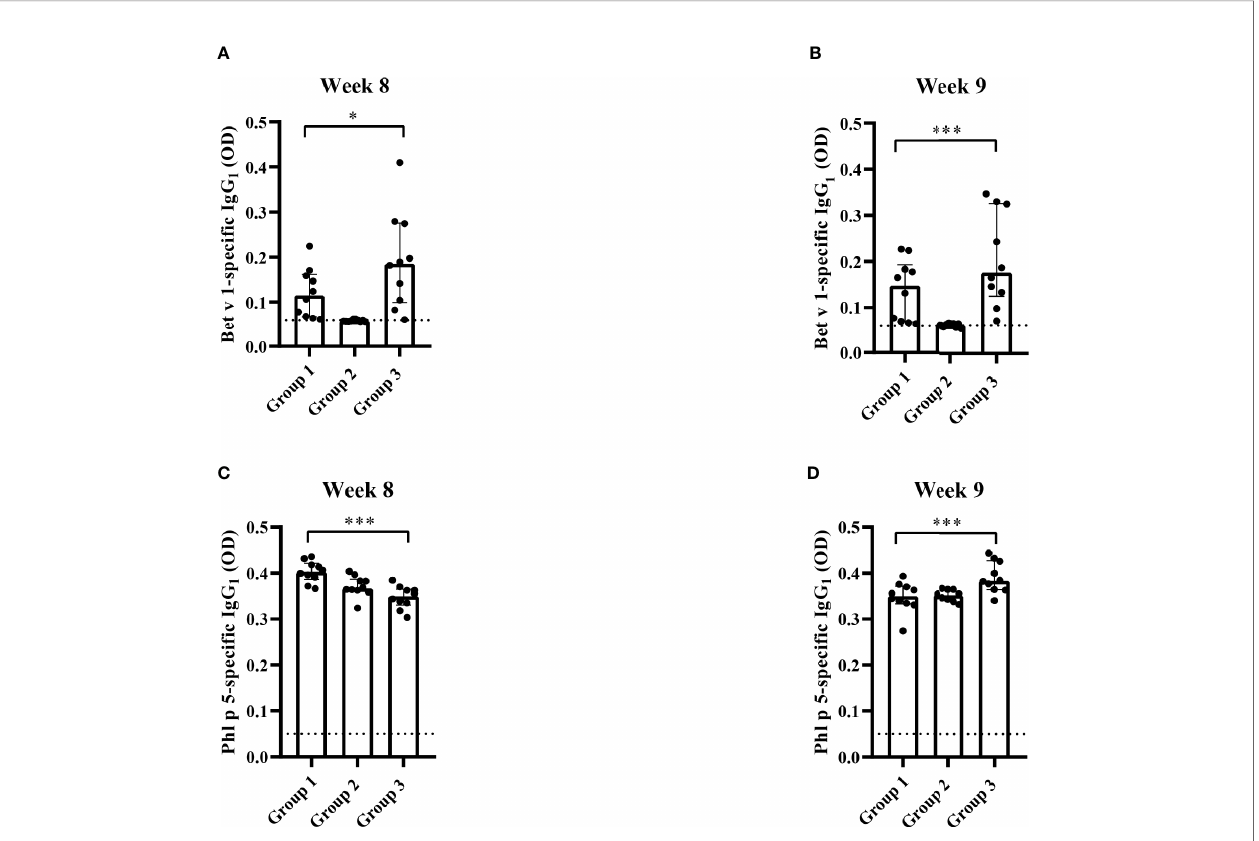
FIGURE 11 | Allergen-speci fi c IgG 1 responses after fi ve prophylactic administrations of Bet v 1 peptides. Bet v 1-speci fi c IgG1 levels in the three mouse groups at week 8 (A) and at week 9 (B) . Phl p 5-speci fi c IgG1 levels in the three mouse groups at week 8 (C) and at week 9 (D) . Serum levels were measured as duplicates for each mouse with a deviation of less than 10% (y-axes: optical density OD levels). Results are displayed as scatter plots with group medians with interquartile ranges. Dotted horizontal bars indicate the cut-off levels for the antibody measurements. Data were analyzed by a general linear model with a log link, comparing group 1 and 3 by linear contrast. Statistically signi fi cant differences between group 1 and group 3 are indicated (***P < 0.001, *P <